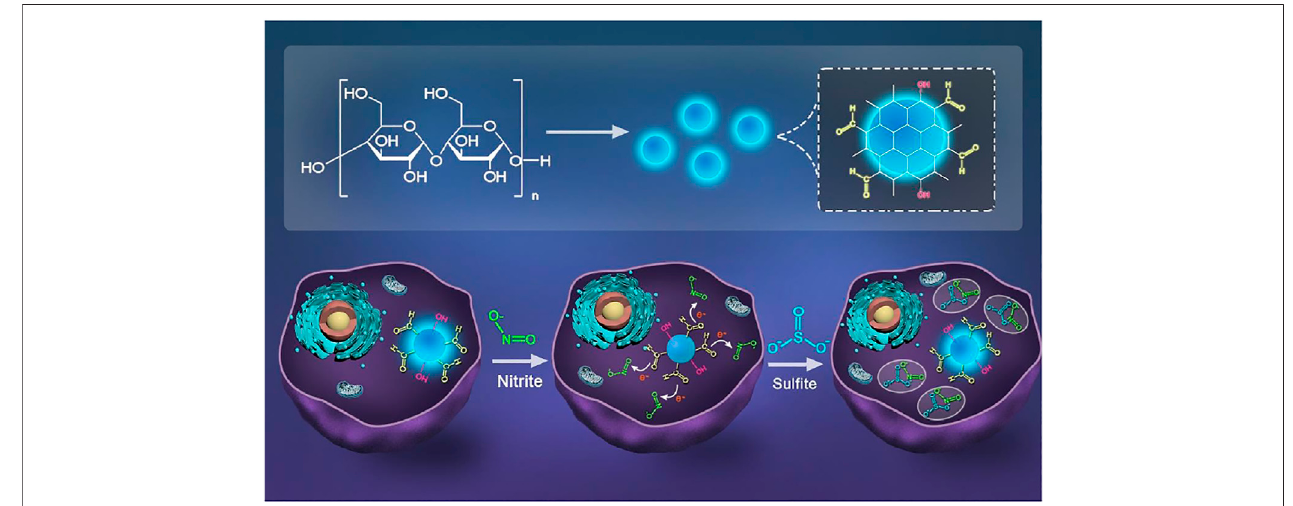
FIGURE 1 | Scheme of synthesizing CDs and schematic illustration for the CDs detection of NO 2- and SO 32- in cells.